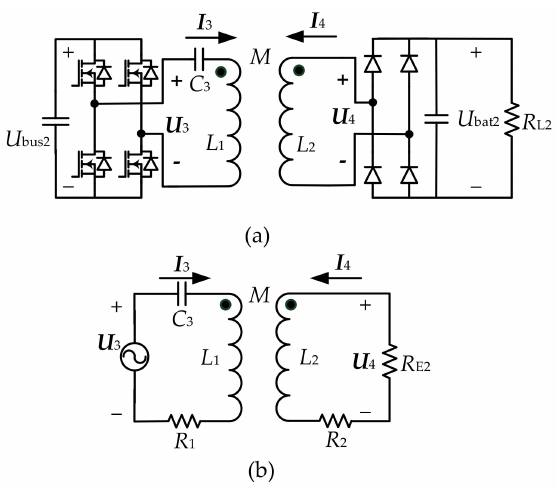
Figure 2. The SN-compensated IPT system. ( a ) The circuit topology; ( b ) the equivalent